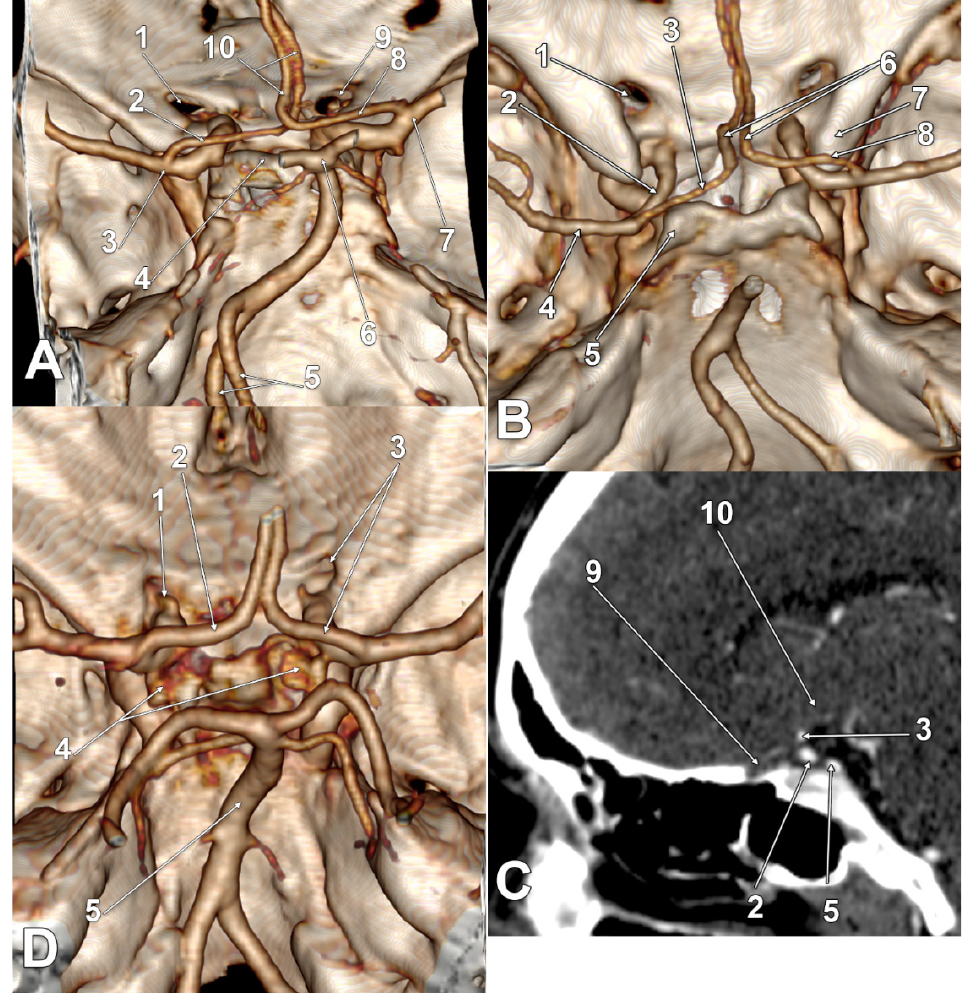
Figure 3. ( A ) Three-dimensional volume rendering of the skull base, right posterosuperior view. Bilateral supracarotid and infrachiasmatic anterior cerebral arteries. 1. Left optic canal; 2. A1 segment of the left anterior cerebral artery; 3. left internal carotid artery bifurcation; 4. dorsum sellae; 5. twisted vertebral arteries; 6. basilar artery bifurcation; 7. right internal carotid artery bifurcation; 8. A1 segment of the right anterior cerebral artery; 9. right optic canal; 10. twisted A2 segments of the anterior cerebral arteries. ( B ) Three-dimensional volume rendering of the skull base, posterosuperior view. ( C ) Sagittal slice through the right optic nerve of the case in ( B ). Posteriorly displaced carotid bifurcations and resulting infraoptic A1 segments of the anterior cerebral arteries. 1. Left optic nerve canal; 2. left internal carotid artery; 3. infraoptic A1 segment of the left anterior cerebral artery; 4. left middle cerebral artery; 5. left posterior clinoid process; 6. prechiasmatic A2 segments of the anterior cerebral arteries; 7. right anterior clinoid process; 8. infraoptic A1 segment of the right anterior cerebral artery; 9. left optic nerve; 10. optic chiasm. ( D ) Three-dimensional volume rendering of the skull base, posterosuperior view. Posteriorly displaced carotid bifurcations and resulting infraoptic A1 segments of the anterior cerebral arteries. 1. Left ophthalmic artery; 2. A1 segment of the left anterior cerebral artery; 3. right optic canal, A1 segment of the right anterior cerebral artery; 4. posterior clinoid processes; 5. basilar artery.